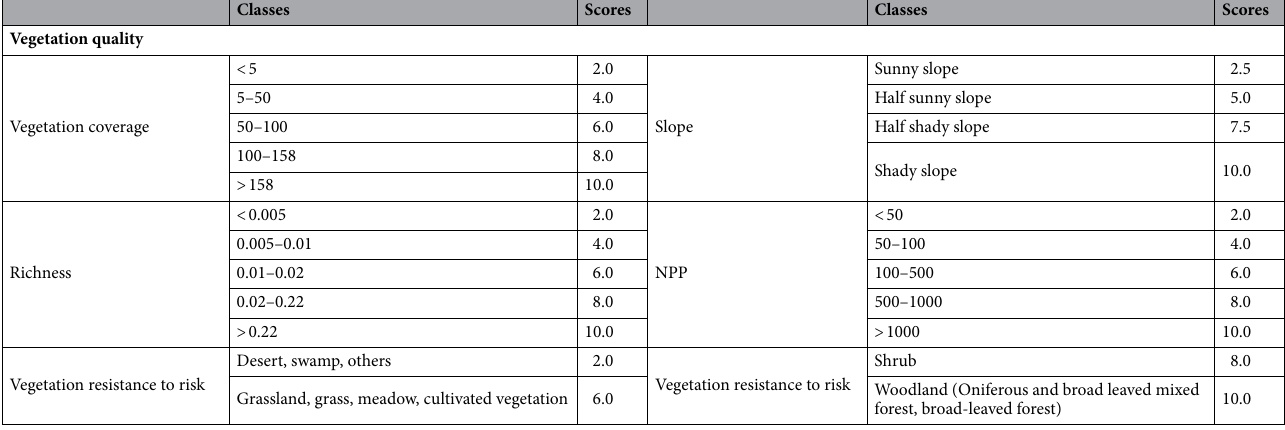
Table 6. The scores of various indices of vegetation quality on the